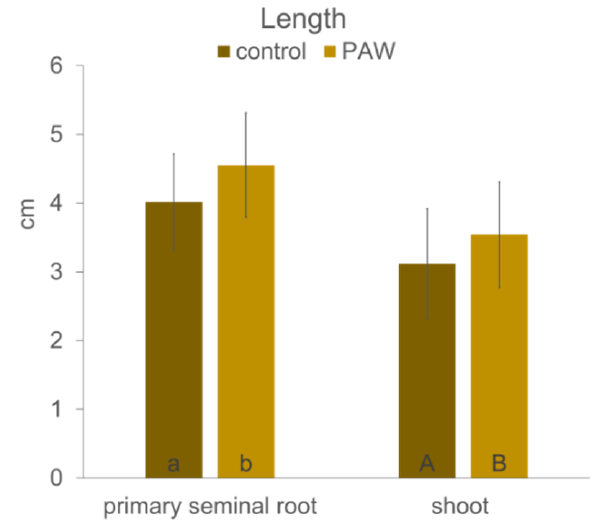
Figure 2. Growth of the primary seminal root and the shoot of maize (hybrid Bielik) after 3 days of cultivation in the paper rolls as control or treated with PAW. Values are means of four replicates ± SD. Different letters denote a significant difference between the treatments.